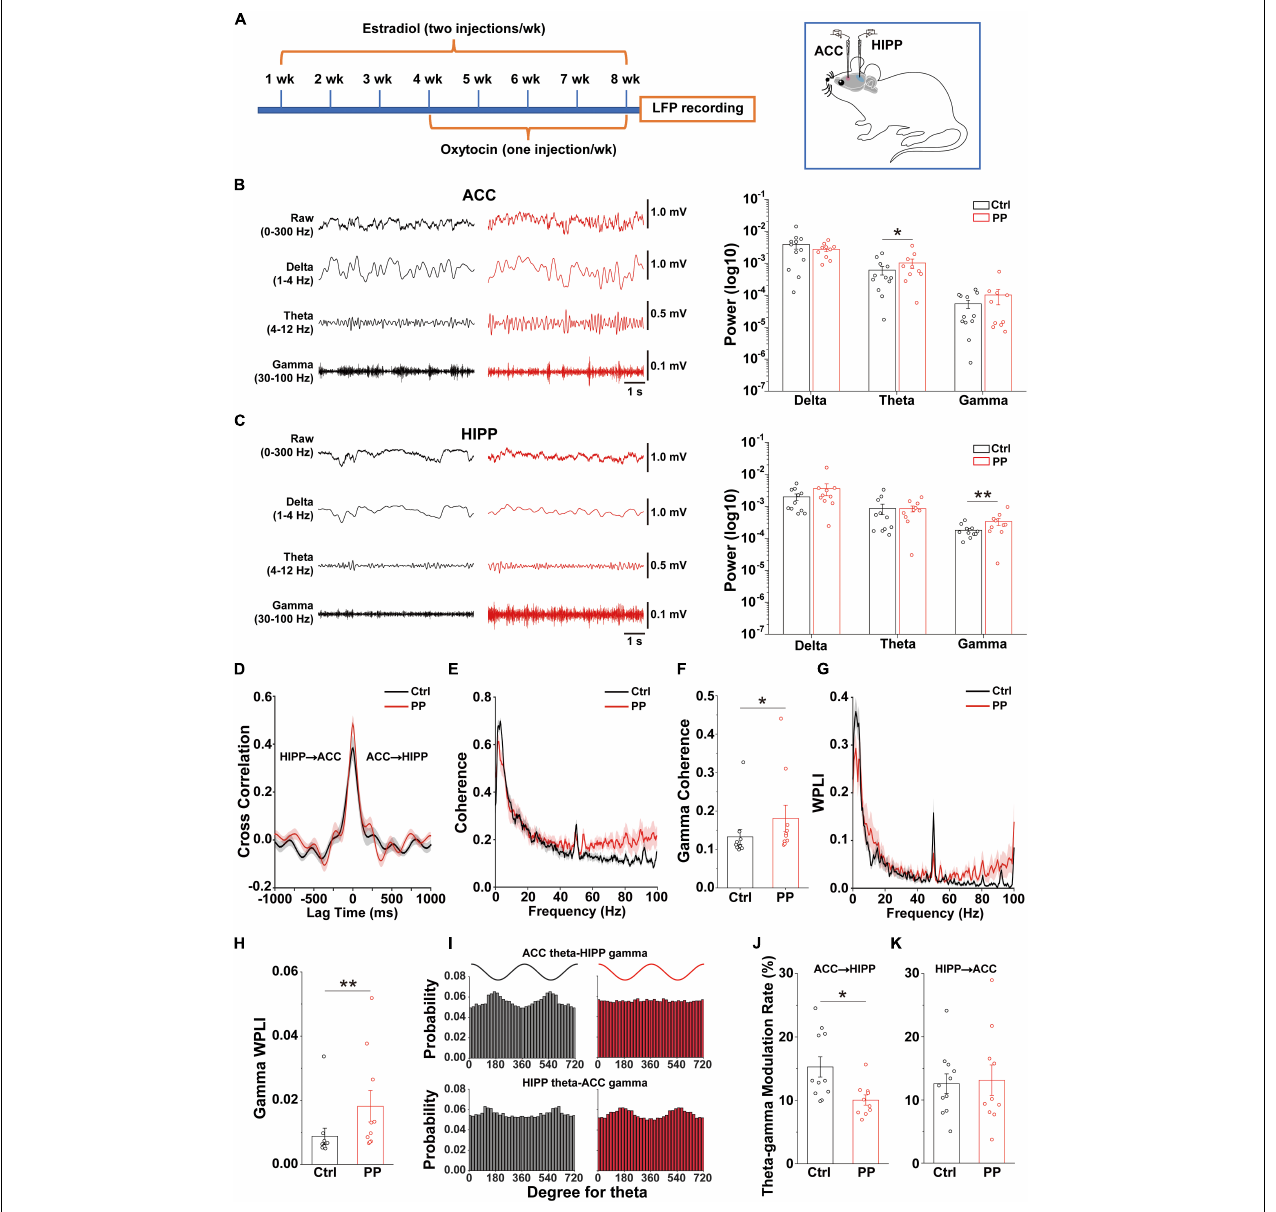
FIGURE 5 | Altered oscillations and connectivity in ACC and HIPP of model rats. (A) Schematic diagram showing the timeline of model rat’s generation and dual channel in vivo LFP recordings in the left hemisphere. Starting from week 4, oxytocin was IP injected 24 h after injection of estradiol. The last dose of oxytocin was injected on day 57 and LFPs were recorded on days 58 and 59. (B) Representative traces of extracellular LFPs, as well as filtered delta, theta and gamma oscillations in the ACC of both groups (left). ACC oscillatory power in the theta band increases significantly in model compared to control rats, while delta and gamma oscillations remain identical between the two groups ( z = –0.281, p = 0.779 for delta; z = –2.209, p = 0.027 for theta; z = 0.114, p = 0.909 for gamma; Mann–Whitney test). (C) Representative traces of extracellular LFPs, as well as filtered delta, theta and gamma oscillations in the HIPP of both groups (left). HIPP of model rats show significantly increased oscillatory power in the gamma band, while delta and theta oscillations remain identical between the two groups ( z = –1.45, p = 0.147 for delta; z = –0.88, p = 0.379 for theta; z = –2.723, p = 0.006 for gamma; Mann–Whitney test). (D) The simultaneous LFP signals between ACC and HIPP have approximately symmetrical cross-correlation values at positive (ACC leading) and negative (HIPP leading) time lags in model and control animals, suggesting bidirectional communication between these two brain areas. (E) Averaged coherence curve between LFPs in ACC and HIPP. Notably, model rat differs significantly from control rats in the gamma band. (F) Gamma coherence between ACC and HIPP in model rats is significantly higher than that of controls (z = –2.289, p = 0.022; Mann–Whitney test). (G) Averaged WPLI curve between LFPs recorded in ACC and HIPP. (H) Gamma WPLI between ACC and HIPP is significantly higher in model rats ( z = –2.711, p = 0.0067; Mann–Whitney test). (I) Probability distribution of cross-frequency theta-gamma coupling in both directions. (J,K) Quantification shows significantly reduced modulatory effect of ACC theta on HIPP gamma activity ( p = 0.034), while modulation by HIPP theta of ACC gamma remains unchanged ( p = 0.818; two-way ANOVA). Values represent mean ± SEM. n = 10–12; * p < 0.05, ** p <